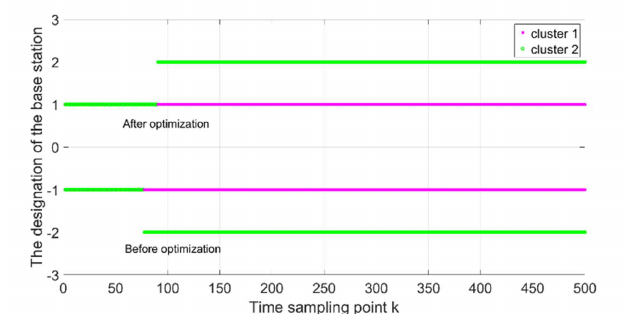
Figure 12. Connection condition between cluster and base station before and after optimization of topology structure. 1 and − 1 of the ordinate represent the connection between base station 1 after and before optimization respectively. 2 and − 2 of the ordinate represent the connection between each cluster and base station 2 after and before optimization